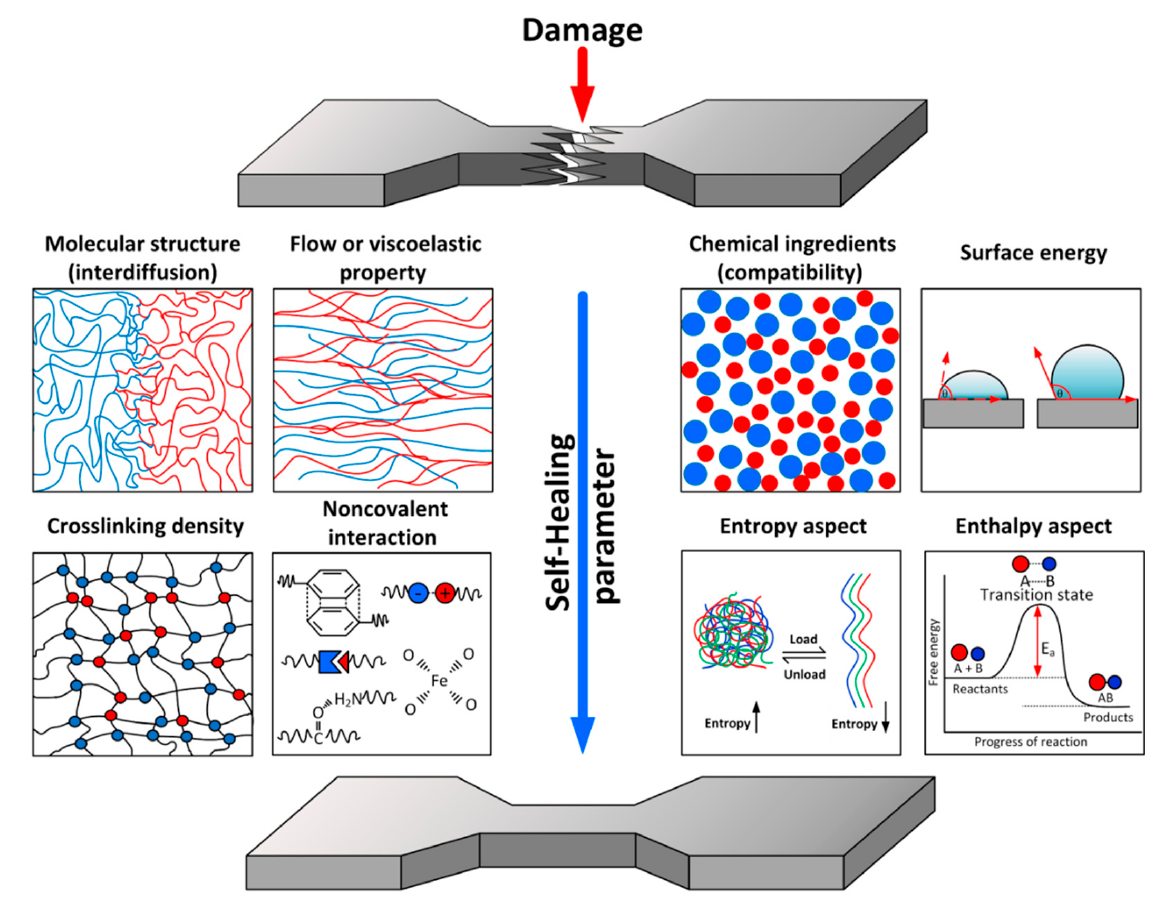
Figure 5. The model of important parameters of the self-healing polymer.